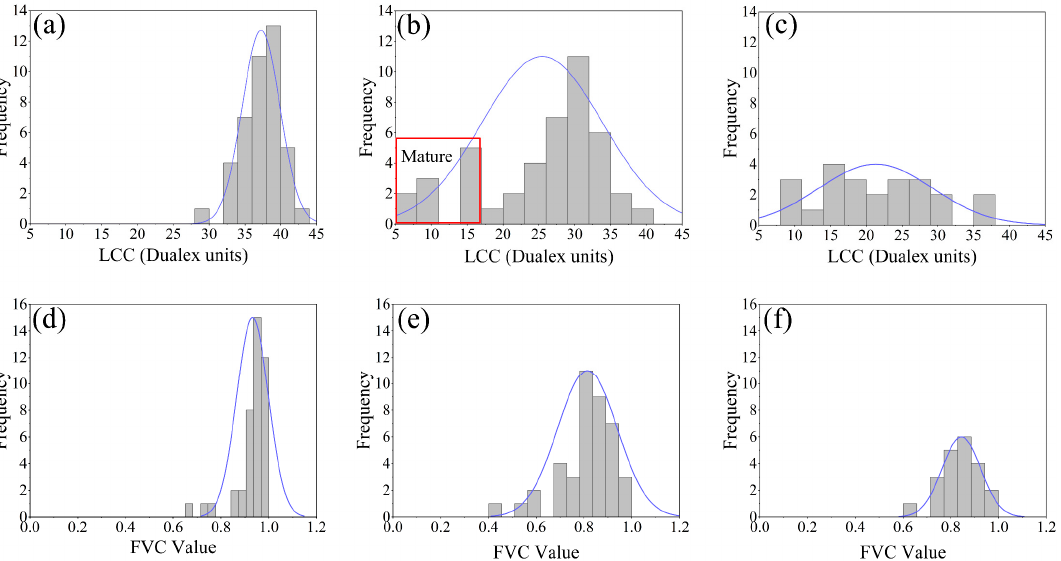
Figure 3. Histograms of the measured LCC and FVC statistics for P2 and P3: ( a ) P2-LCC; ( b ) P3- LCC; ( c ) P4-LCC; ( d ) P2-FVC; ( e ) P3-FVC; ( f ) P4-FVC. Note: The P4 partially mature soybeans had